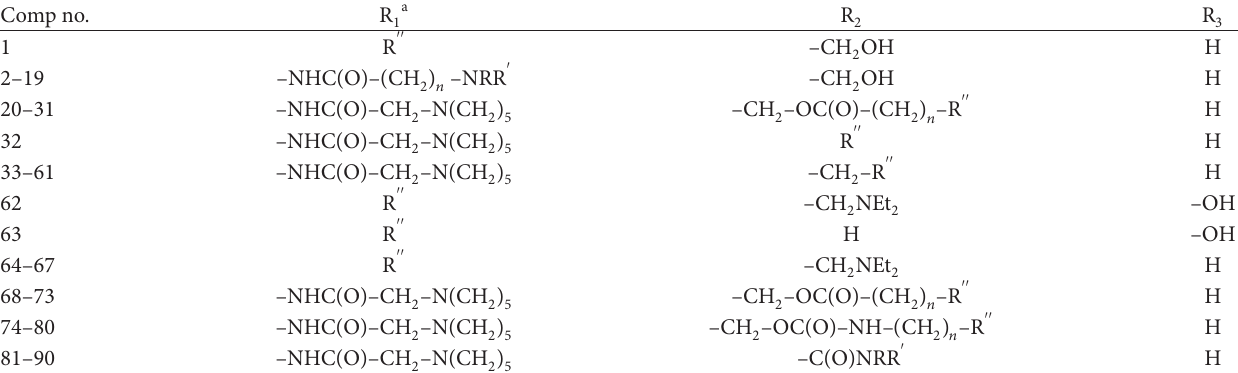
T 1: e variations in substitution positions of anilinoquinolines (Figure